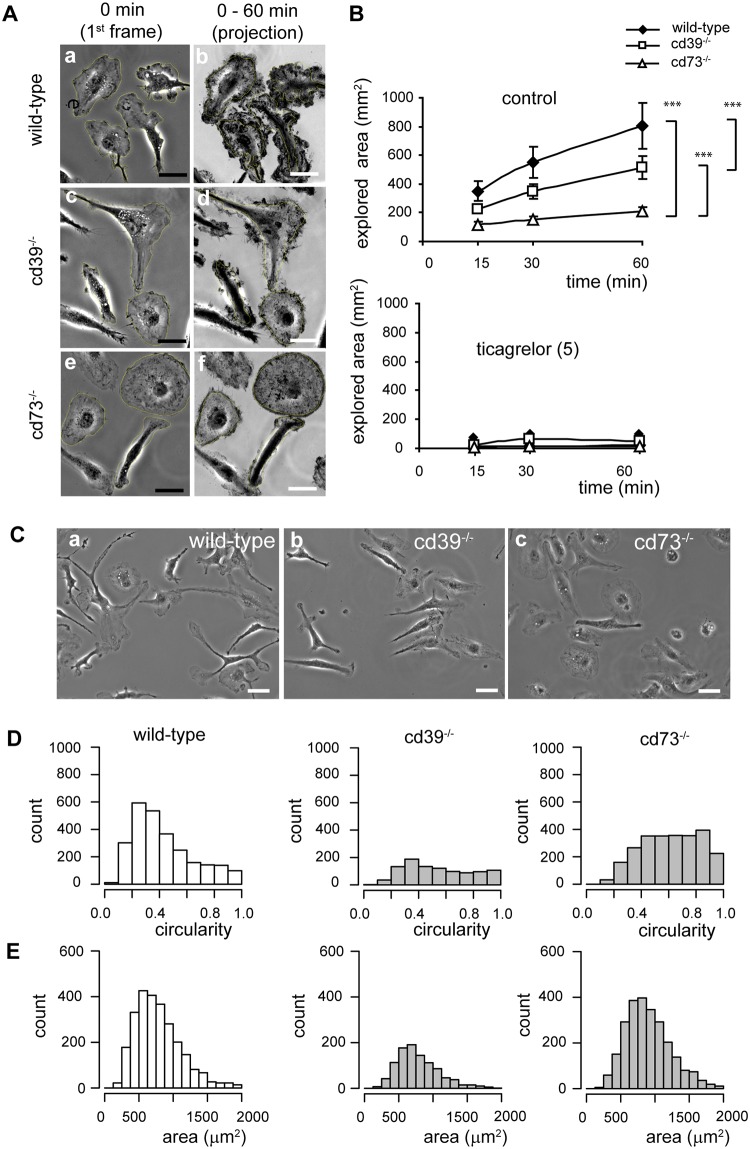
Primary neonatal microglial cells cultured from cd39-/- and cd73-/- mice move more slowly, form fewer protrusions and are more round when compared to wild-type microglia.Cells were monitored by time-lapse video microscopy, and 60 min-long time-series of phase-contrast images were analyzed. (A) A representative first image and a projection of all images in a time-series (60 min) of wild-type (a, b), cd39-/- (c, d) and cd73-/- (e, f) microglia are shown; cells were cultivated under serum-free conditions for no longer than 12 h. Explored areas (during 60 min) were compared, and *** denotes p < 0.001. (B) Summary of the area covered by cells (explored area) during 15, 30 and 60 min. The explored area resulted from protrusions of processes and a translocation of the cell body; explored area was measured as a difference between the entire area which was marked by a cell during the defined period and the cell area measured on the first image. Microglial cells were cultivated under serum-free conditions (control, upper panel) or in the presence of the P2Y12 receptor inhibitor ticagrelor (5 μM, bottom panel). Knockout microglia were significantly slower in comparison to wild-type cells, and ticagrelor abrogated the exploring activity of microglia. (C) Phase-contrast images of wild-type (a), cd39-/- (b) and cd73-/- (c) microglia cultivated for 24 h in a serum-free medium are shown. Scale bar is 20 μm. Histograms show the distribution of cell circularity (D) and cell area (E) of wild-type (N = 2590), cd39-/- (N = 1100) and cd73-/- (N = 2490) microglia; N represents the number of individual cells. For every genotype, circularities and cell areas were collected from at least 1000 cells from 5 independent primary cell cultures; at least 200 individual cells per culture dish were measured. Significant differences were tested by one-way ANOVA, and *** denotes p < 0.001 in comparison to control.